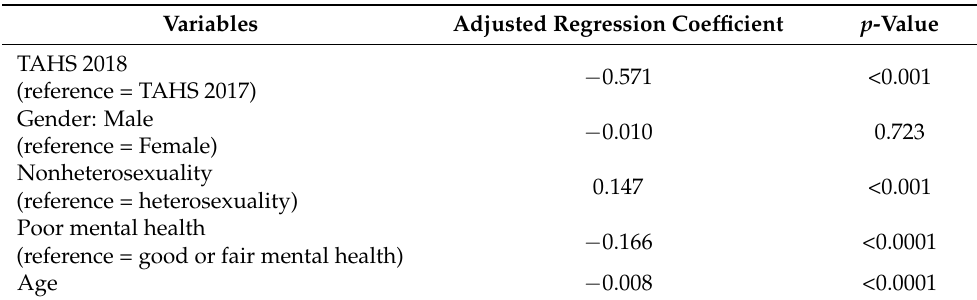
Table 2. Association of survey year, gender, sexual orientation, mental health, and age with perceived attitudes toward homosexuality: multiple regression